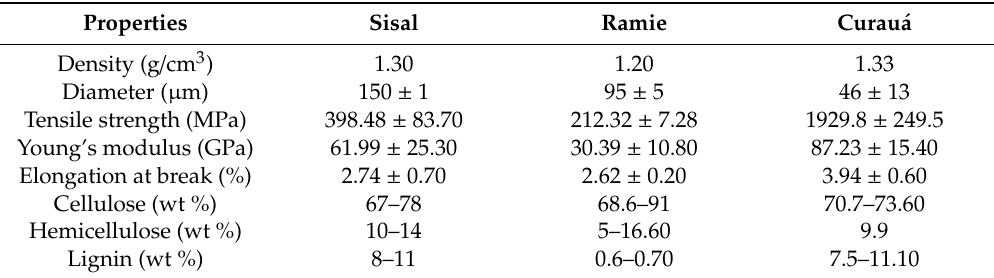
Table 1. Chemical composition, physical and mechanical properties of the natural fibers